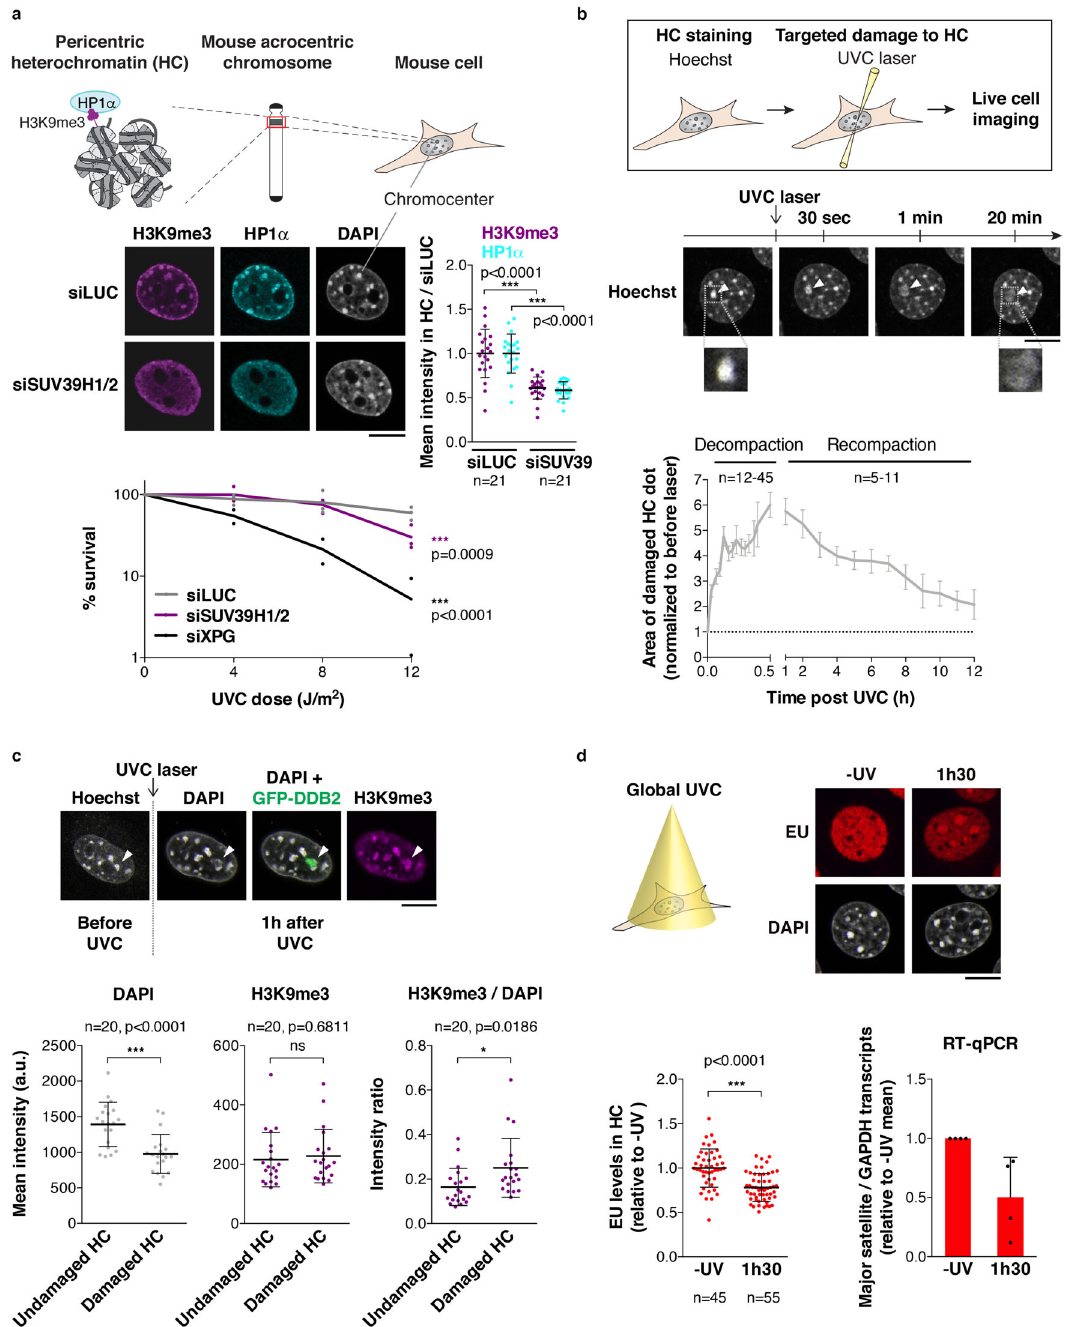
Fig. 1 Heterochromatin integrity is maintained in response to UV damage. a Schematic representation of pericentric heterochromatin domains in mouse cells and delocalization of heterochromatin marks (H3K9me3, HP1 α ) upon knockdown of SUV39H1/2 methyltransferases in NIH/3T3 GFP-DDB2 cells. Clonogenic survival of the same cell line treated with the indicated siRNAs (siLUC, negative control; siXPG, positive control) and exposed to global UVC irradiation. b Technical approach for targeting UVC damage to pericentric heterochromatin domains (HC) in live murine cells. Heterochromatin compaction changes upon UVC laser micro-irradiation are analyzed by live imaging in NIH/3T3 GFP-DDB2 cells stained with Hoechst. White arrowheads point to UVC-damaged heterochromatin domains. c H3K9me3 levels in damaged heterochromatin (white arrowheads) analyzed by immuno fl uorescence in NIH/3T3 GFP-DDB2 cells 1 h after UVC laser micro-irradiation. Scatter plots represent DAPI and H3K9me3 levels measured on reconstructed 3D images in damaged heterochromatin (HC) domains compared to undamaged heterochromatin in the same nucleus. d Heterochromatin transcription analyzed 1h30 after global UVC damage in NIH/3T3 GFP-DDB2 cells by EU staining ( fl uorescence images and left graph) and by RT-qPCR for major satellite transcripts (right graph). Data are presented as mean values ± SD (SEM for ( b ) panel only) from four experiments (( d ), right graph) or from n cells scored in at least three independent experiments. Statistical signi fi cance is calculated via two-sided Student ’ s t test with Welch ’ s correction when necessary ( a , c , d ). Comparisons of clonogenic survival in ( a ) are based on non-linear regression with a polynomial quadratic model. a.u. arbitrary units. All microscopy images are confocal sections. Scale bars, 10 μ m. Zoomed in views of heterochromatin domains (×2.6). Source data are provided as a Source Data fi le.